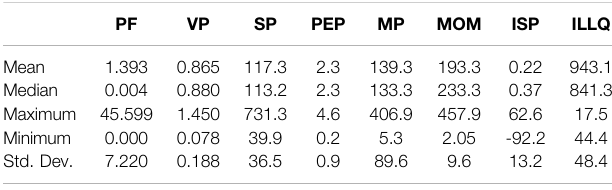
TABLE 1 | Descriptive analysis.